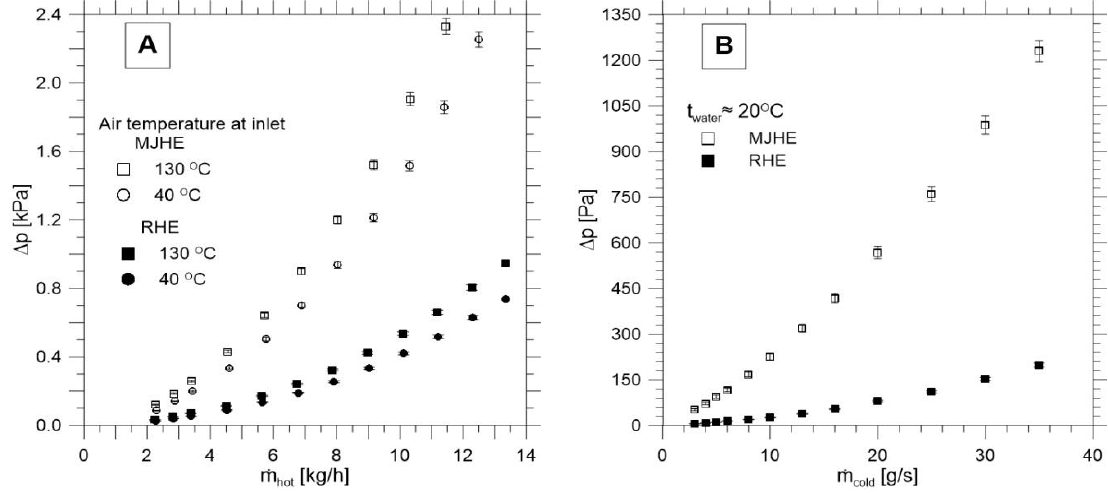
Figure 5. Flow characteristics of MJHE and RHE for: ( A )—heating side (air), ( B )—heated side (water). The hydraulic resistance on the heating side (air) increases with the increasing